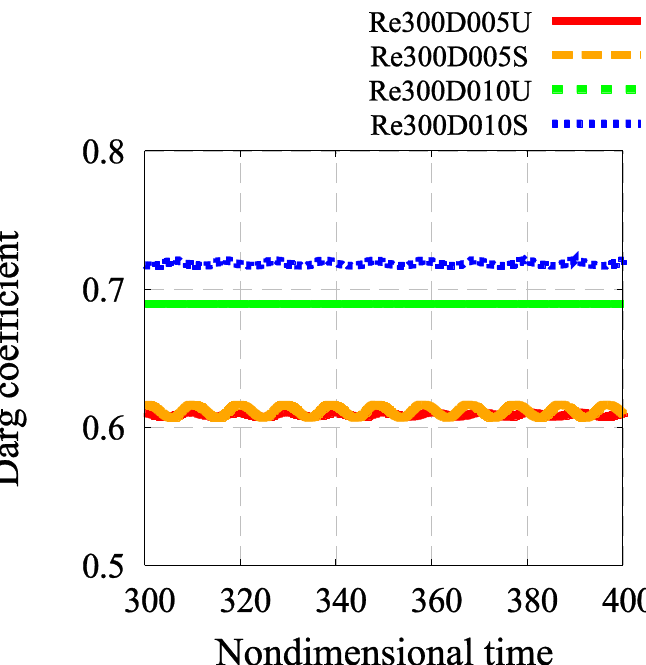
Figure 5. Variation of drag coefficient at Re = 300.